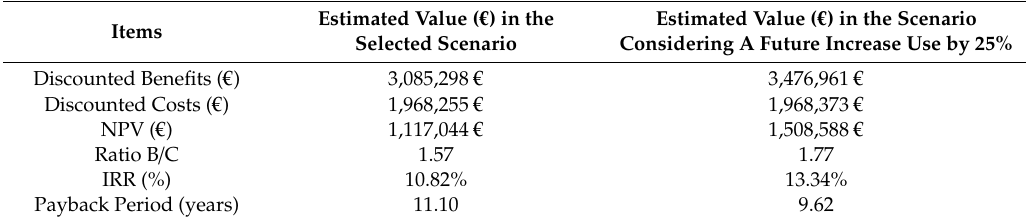
Table 5. Economic assessment of Thinking Fadura. Time horizon 20 years and discount rate